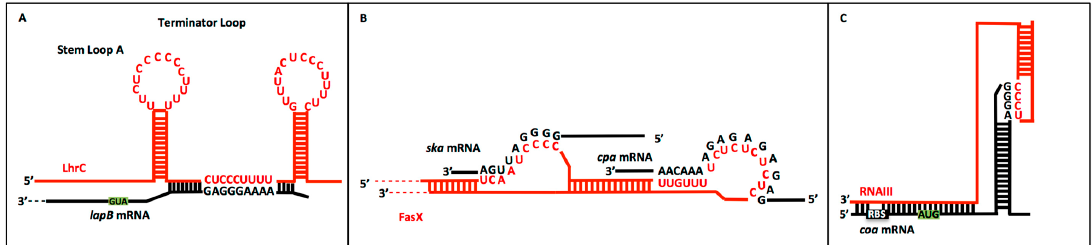
Figure 2. CU-rich motifs in the binding sites of sRNA to target mRNA appear to be conserved in gram-positive bacteria. Small RNAs are designated as red and target mRNAs are designated as black. The bolded nucleotides highlight the CU-rich motifs involved in sRNA:target RNA binding. ( A ) Predicted model of LhrC: lapB mRNA interaction in L. monocytogenes. An initial “kissing” interaction occurs between the loop structures of LhrC and the lapB mRNA through CU-rich motifs to increase specificity and is followed by straight region binding. This binding inhibits further transcription of the lapB gene by inducing the formation of a transcription terminator in the nascent lapB mRNA. Mutations of the CU-rich motif in either loop greatly decrease interaction between the RNAs, indicating the CU-rich motifs are necessary for target recognition; ( B ) Predicted model of FasX:target mRNA interaction in S. pyogenes. FasX utilizes two separate regions of conserved CU motifs for the binding to target mRNAs ska ( streptokinase) and cpa (pilus) . The FasX: ska mRNA interaction creates a 10-fold increase in mRNA abundance and positively regulates gene expression as long as FasX remains bound. Through another loop structure in FasX, it also regulates expression of the cpa mRNA by reducing ribosome availability to the transcript; ( C ) Predicted model of RNAIII: coa mRNA interaction in S. aureus. The binding between RNAIII and the coa mRNA via a loop–loop interaction induces structural changes surrounding the ribosome binding site. These changes mask the ribosome binding site and prevent coa translation. 5’-AUG in the green background (Figure 2A,C) represents the start codon, and RBS in the black background (Figure C) indicates the ribosome binding site.